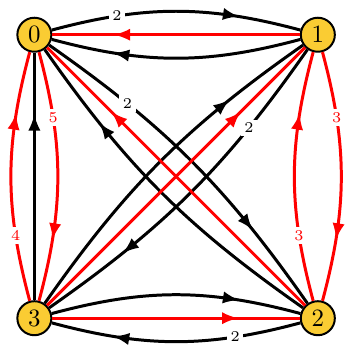
Figure 10. Quiver for the conifold × conifold. Black arrows have degree 0 and red arrows have degree 2 . They correspond to 0 d N = 1 chiral and Fermi fields,